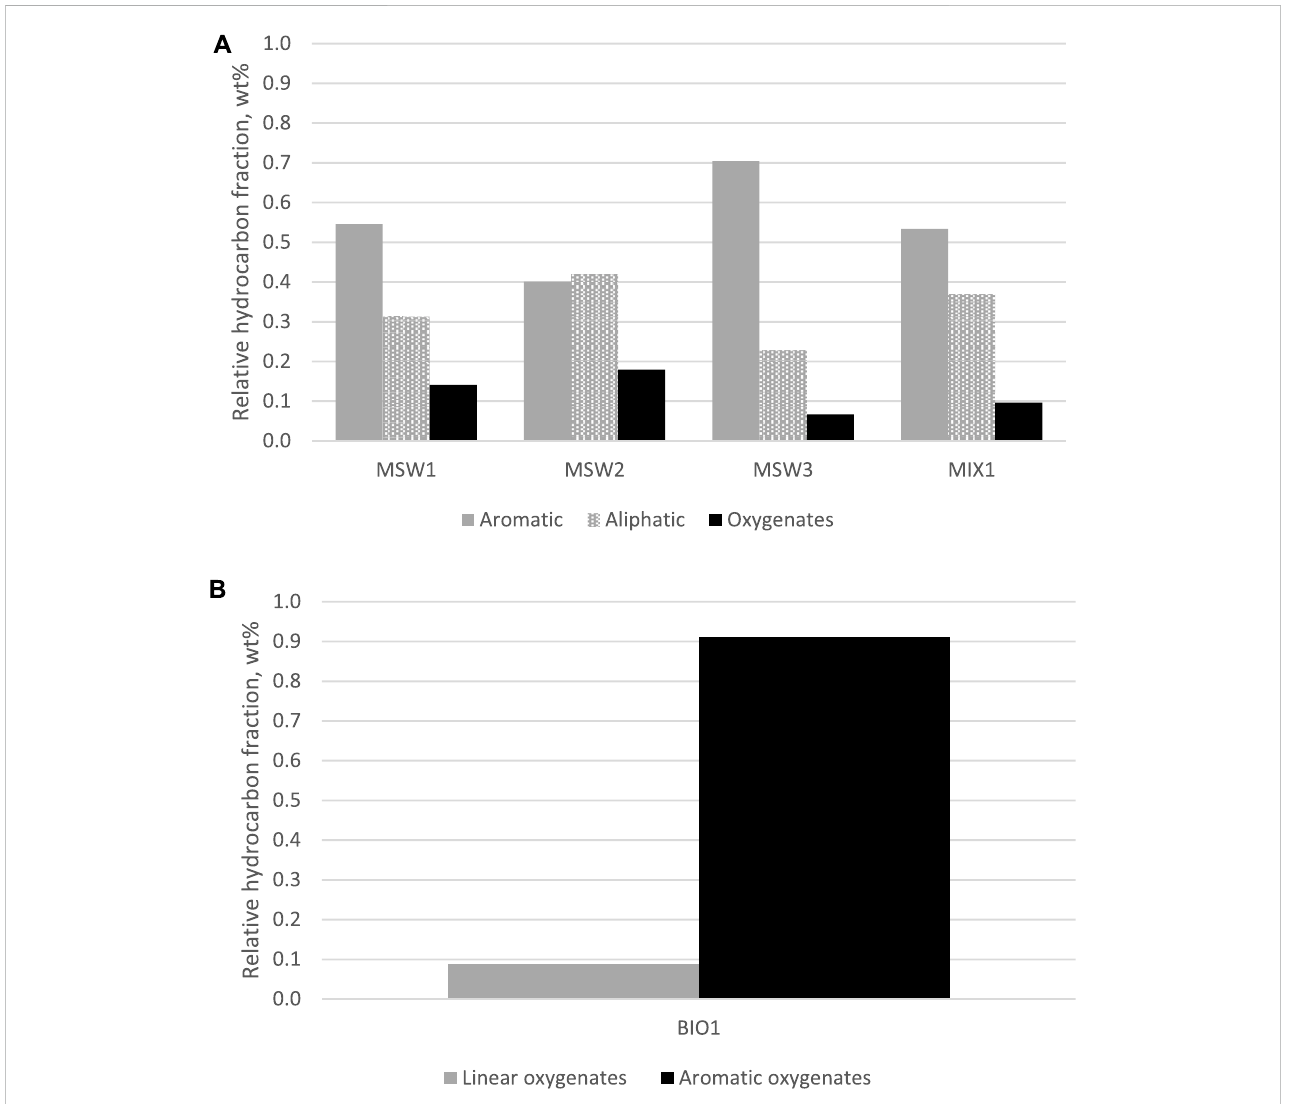
FIGURE 2 Dominant compounds found in pyrolysis oils; relative aromatic, aliphatic, and oxygenate hydrocarbon distribution in MSW-derived pyrolysis oils (A) , top and relative linear and aromatic oxygenate hydrocarbon distribution in biomass-derived pyrolysis oil (B) ,